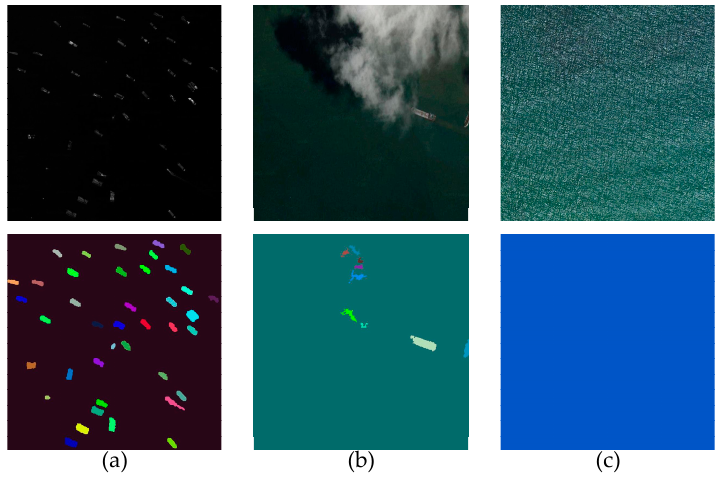
Figure 5. The optical remote sensing (ORS) images and the corresponding segmentation results. ( a ) Ship targets with uneven brightness and low contrast. ( b ) Ship targets disturbed by the clouds. ( c ) No target in the ORS image.